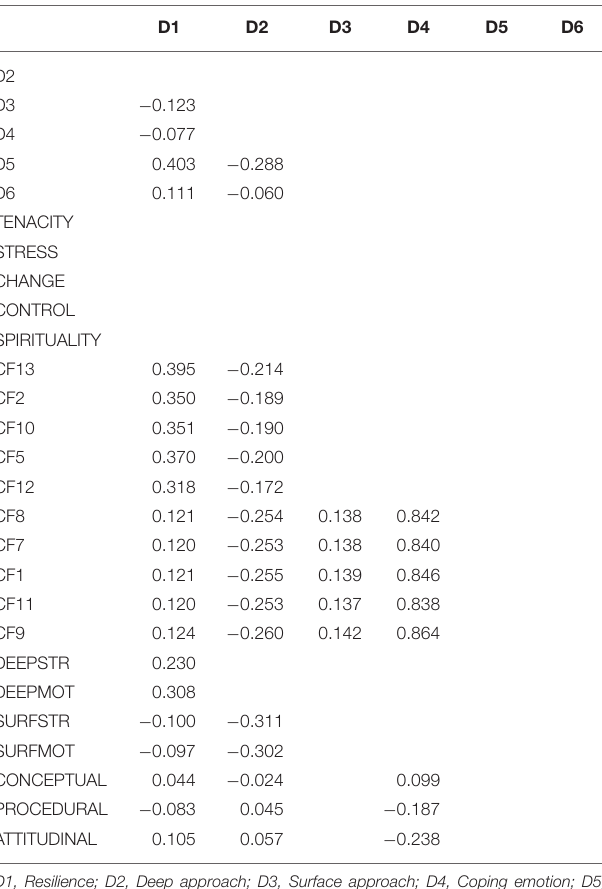
Table 8 | Standardized direct effects (Default model). Table 9 | Standardized indirect effects (Default